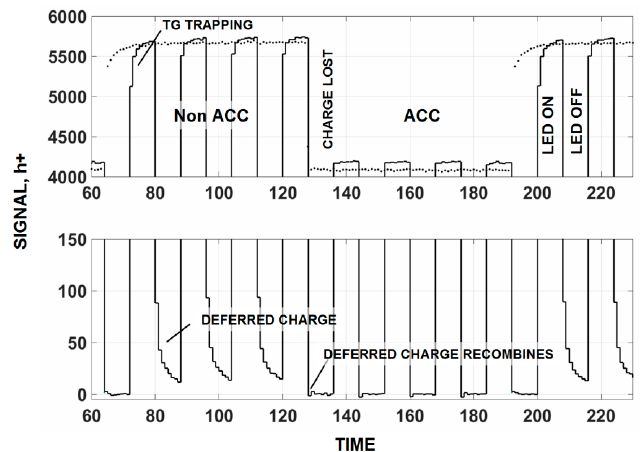
Figure 18. Response for a troubled imager when the transfer gate (TG) is switched in and out of accumulation. Deferred and recombination loss are clearly seen for the device. The top trace shows how charge is trapped whereas the lower trace shows how trapped charge is released and deferred in time.